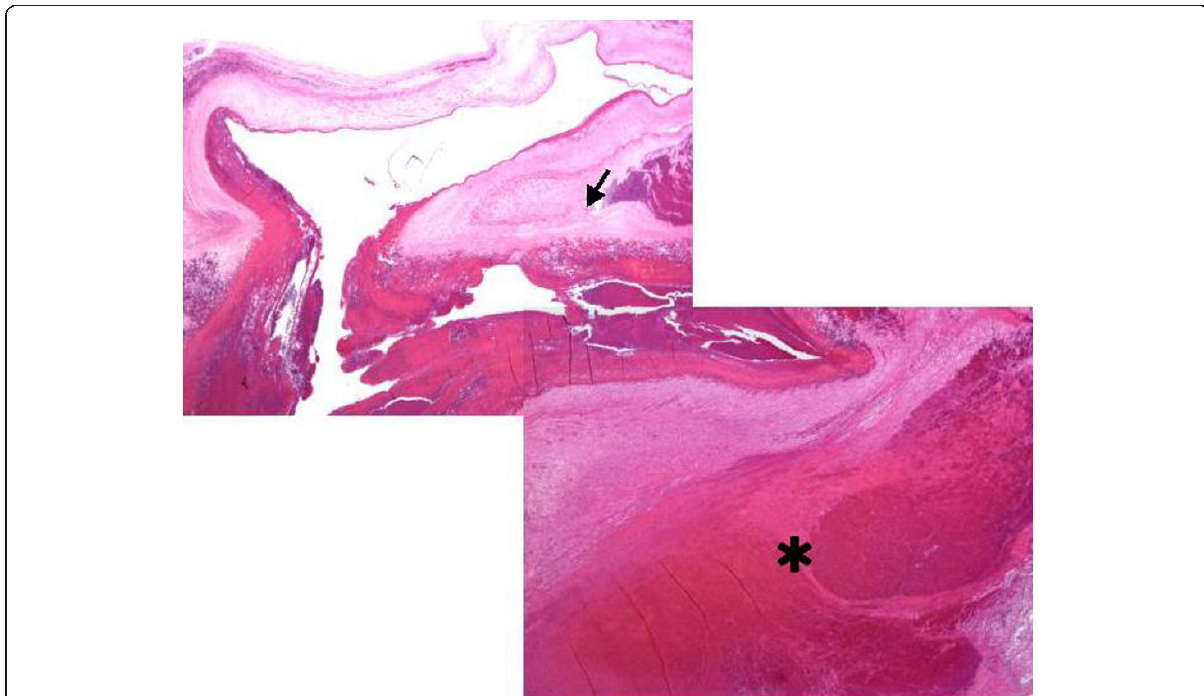
Figure 4 Merged photographs of a dilated chorionic plate vessel . The smooth muscle of the dilated chorionic plate vessel has disappeared (arrow), and the vessel wall has ruptured, producing hemorrhage and the formation of a hematoma (asterisk). (hematoxylin-eosin staining (HE), objective